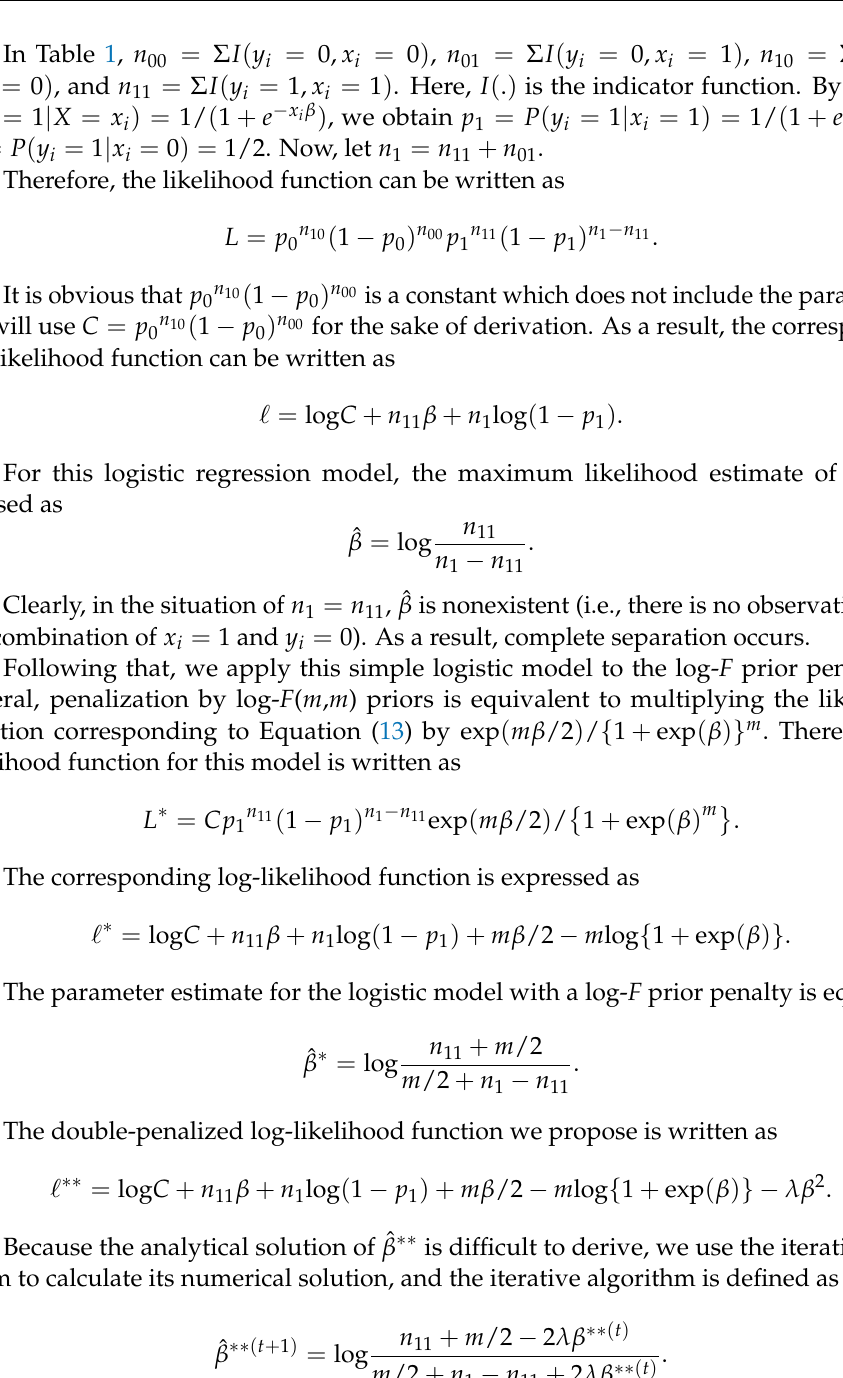
Table 1. A 2 × 2 contingency table of a one-parameter issue without an intercept. x i y i 0 1 0 n 00 n 01 1 n 10 n